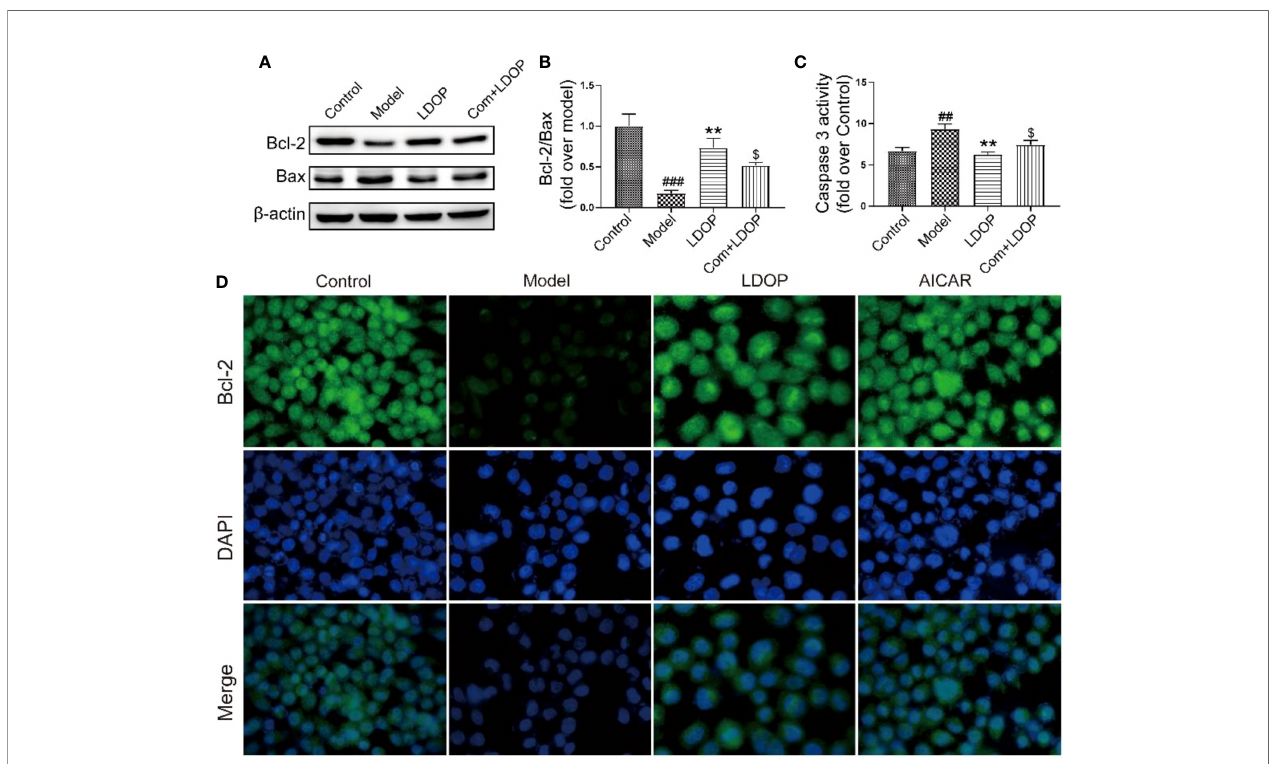
FIGURE 11 | LDOP-1 inhibited the expression of Bax, caspase 3 and boost of Bcl-2. (A) The expression of Bax and Bcl 2 detected by Western blot. (B) Statistical analysis on ratio of Bax to Bcl-2. (C) The production of caspase 3 detected by biochemical markers kit. (D) Immunohistochemical image of Bcl 2 measured by immuno fl uorescence technique. Data are expressed as the mean± SD of three independent experiments. ## P<0.01, ### P<0.001 compare the control group; **P<0.01 compare model group. $ P < 0.05 compare with LDOP-1 group. LDOP stood for